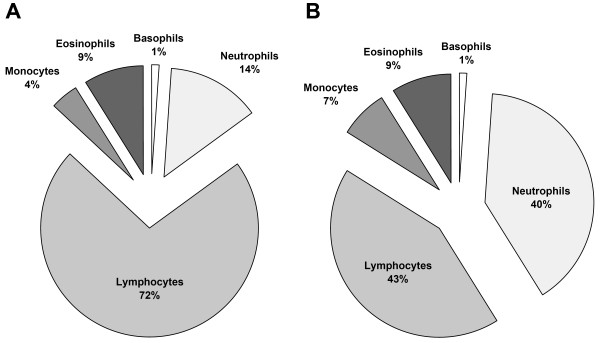
Analysis of leukocyte cell population subset. Analysis of leukocyte cell population subsets were performed on whole blood sampled in vivo for BTB-infected (A) and healthy control cattle (B). The lymphocyte and monocyte subpopulations are retained in peripheral blood mononuclear cells (PBMC).